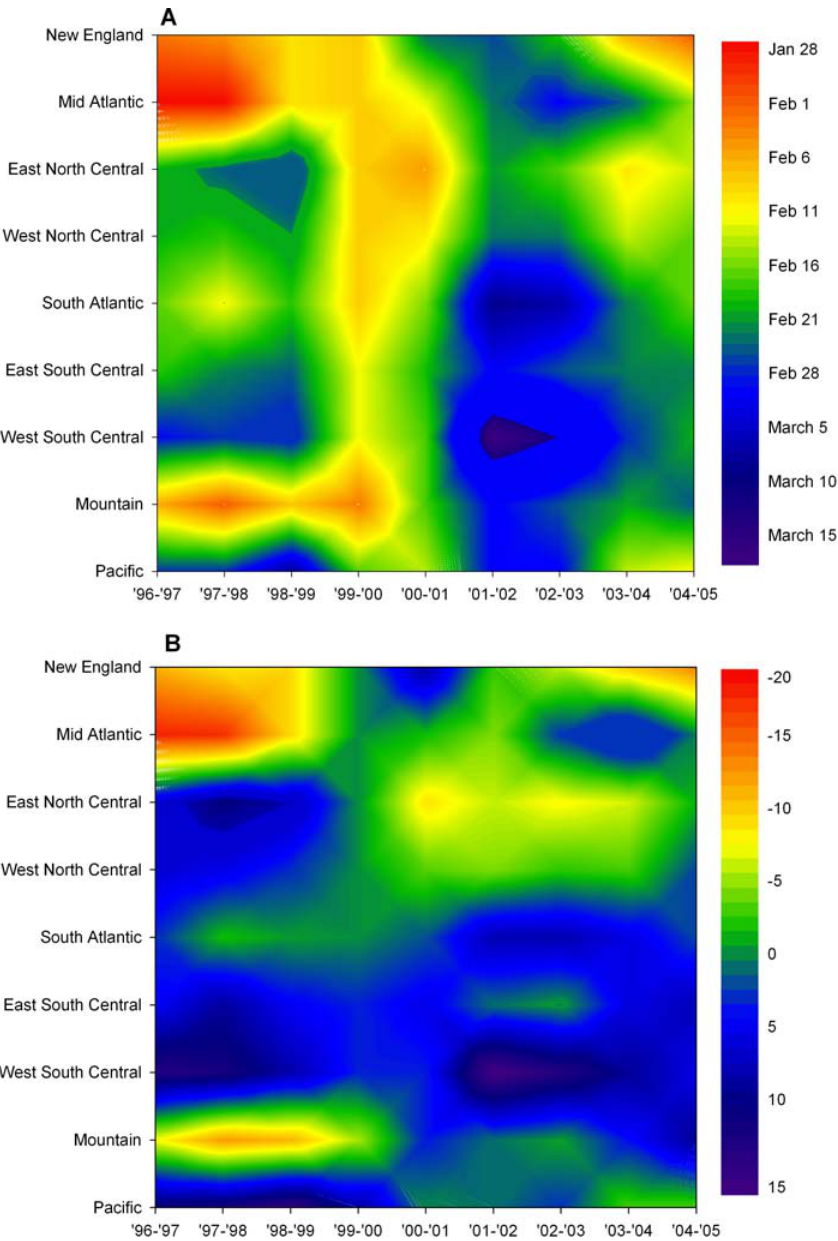
Figure 3. Timing of Influenza Illness across the Nine Major Geographic Regions of the United States (1996–2005) For each influenza year, phase shifts are calculated as the maximum value from cross-correlation of the band-pass filtered weekly P&I mortality data. (A) Contour plot of raw phase shifts between regions for each season, which displays shifts in the absolute timing of influenza mortality peaks from year to year. The plot shows the shifts in the yearly phase, with the 1999–2000 season exhibiting an overall earlier peak and the 2001–2002 season (following September 11, 2001) exhibiting an overall later peak across all regions. (B) Contour plot of demeaned phase shifts, which displays typical regional patterns and relative time to transnational spread. For each season, demeaned phase shifts were calculated by subtracting the mean peak date. The plot reveals increased variation in phase shifts (time to transnational spread) during the earliest influenza seasons, 1996–1997 and 1997–1998, as well as the increased variation during the 2001–2002 influenza season. DOI: